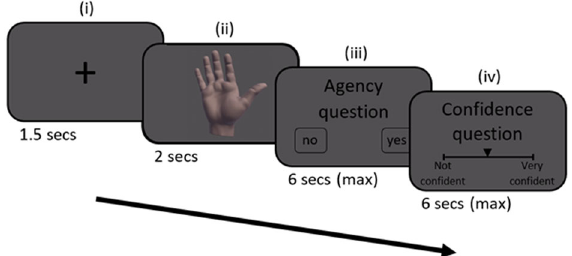
Fig. 3 Trial fl ow. Each trial began with a fi xation cross (i), followed by the VH presentation (ii), agency question (iii) and the con fi dence question